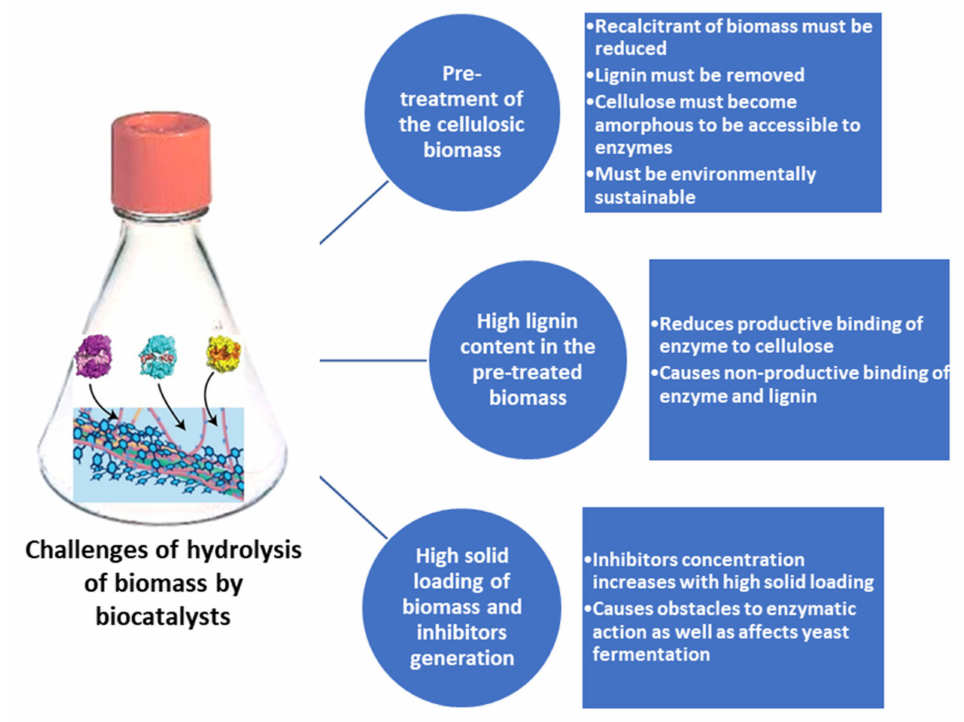
Figure 2. Challenges during biomass hydrolysis via application of